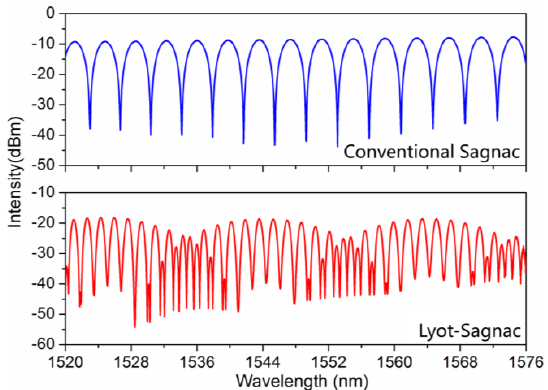
Figure 2. Spectra of the conventional Sagnac and Lyot-Sagnac interferometers.